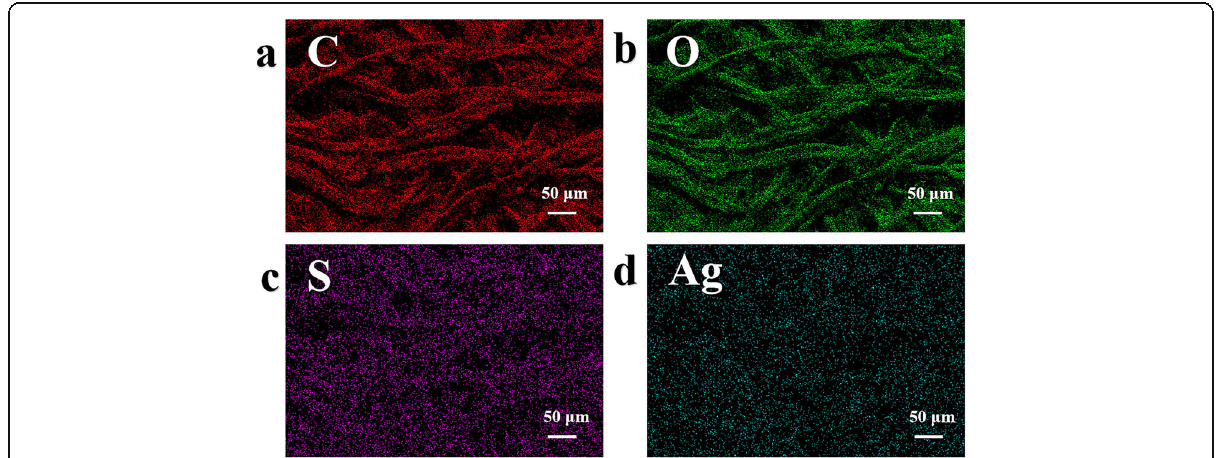
Fig. 3 EDS-mapping images a C, b O, c S, and d Ag of